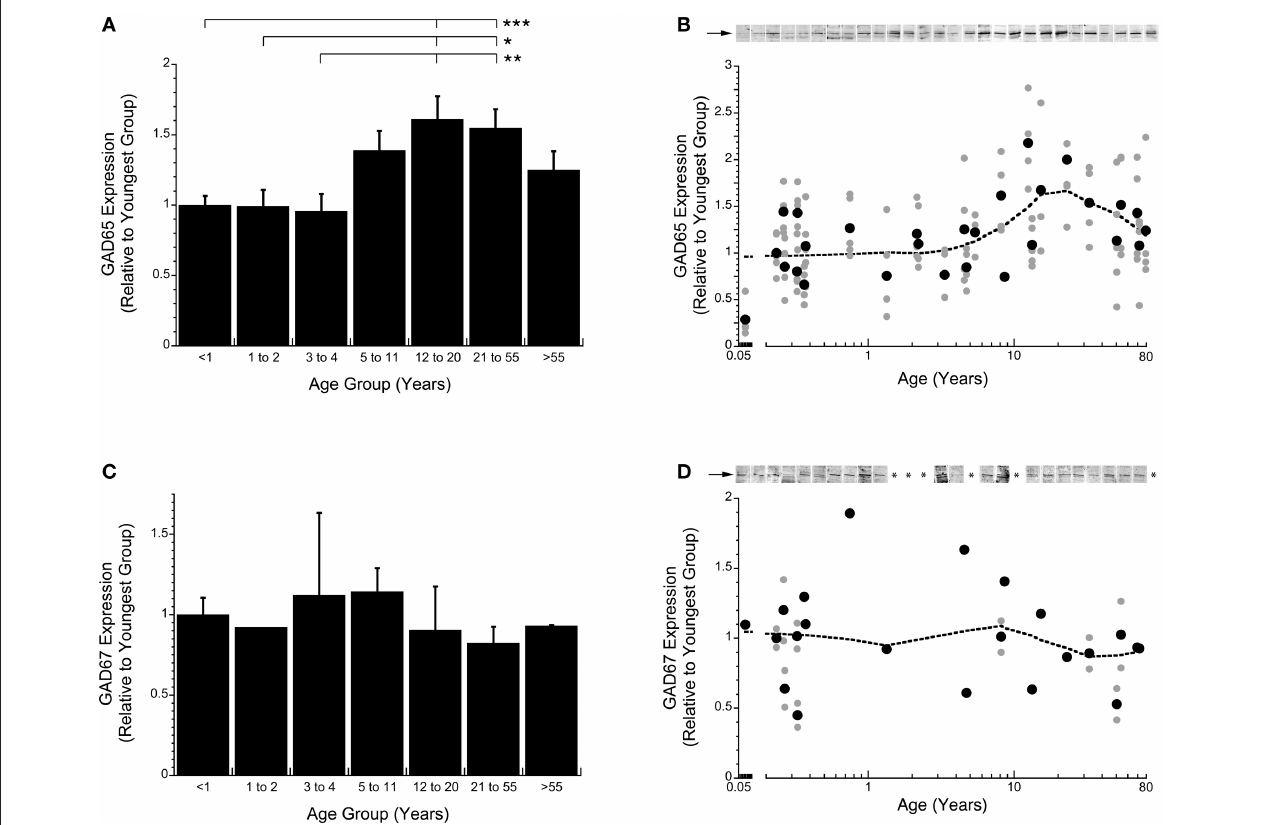
locally weighted least squares method at 50% (dotted line). GAD65 showed a significant change across the lifespan (Kruskal–Wallis, p < 0.0001) with progressive increase in expression levels into the teenage and adult years then a loss with aging (A,B) . There was no change in expression levels of GAD67 across the lifespan (C,D) . The lines above the histograms identify the groups that were significantly different (Tukey’s post hoc HSD, * p < 0.05, ** p < 0.02, *** p <